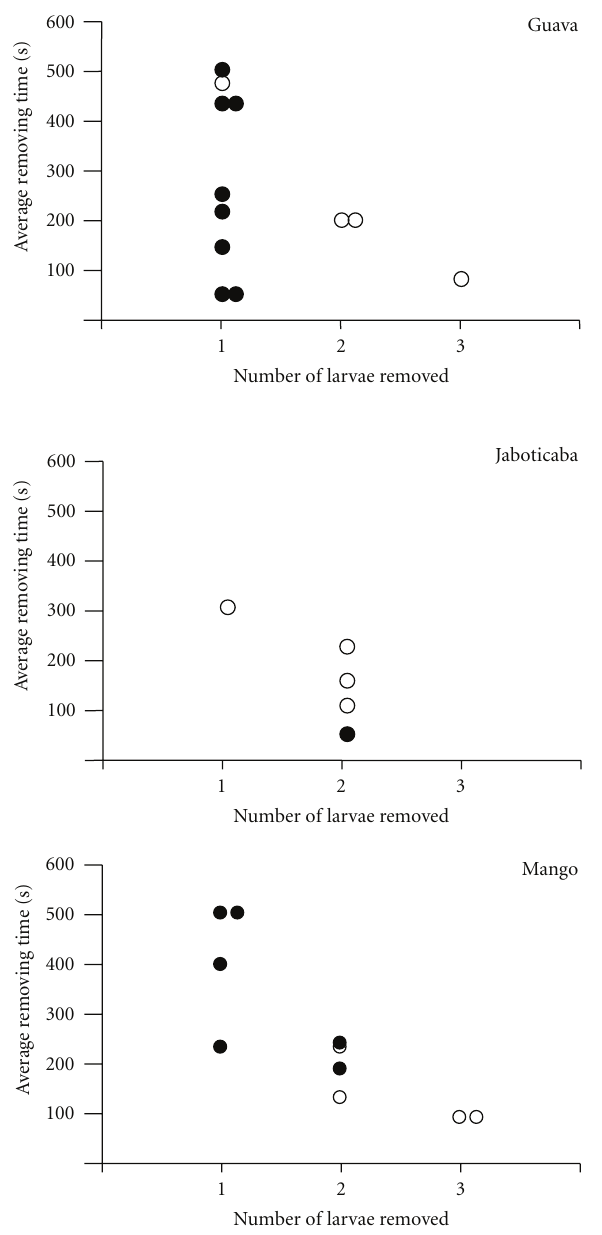
Figure 1: Relationship between amounts of fruit fly larvae (Tephri- tidae) removed by ants and average time for removal of each larva beneath the crowns of three species of fruit trees. Empty points are samples without larvae burying themselves. Guava is Psidium guajava , jaboticaba Myrciaria jaboticaba , and mango Mangifera indica .